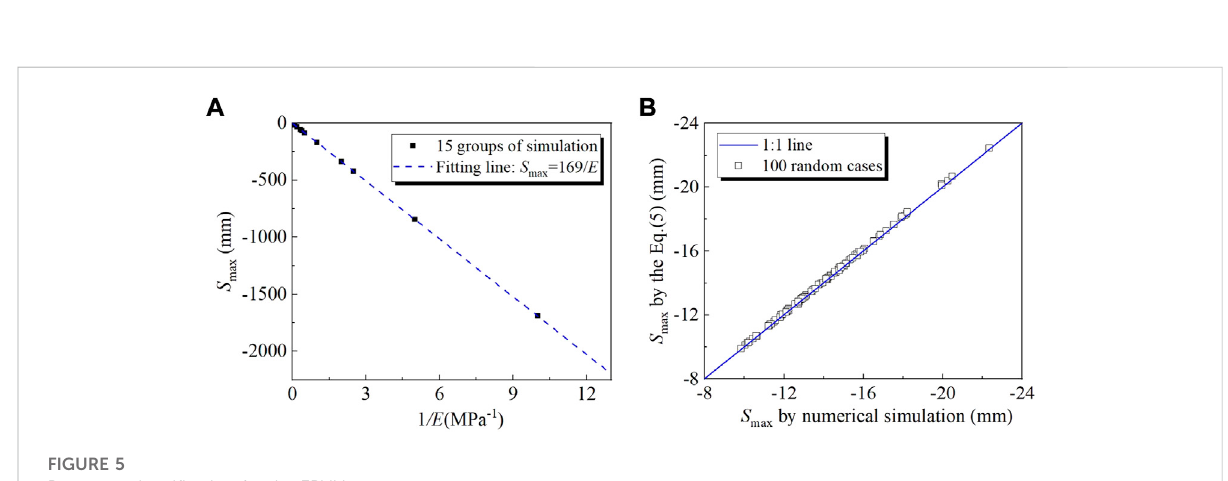
FIGURE 5 Dataset and veri fi cation for the